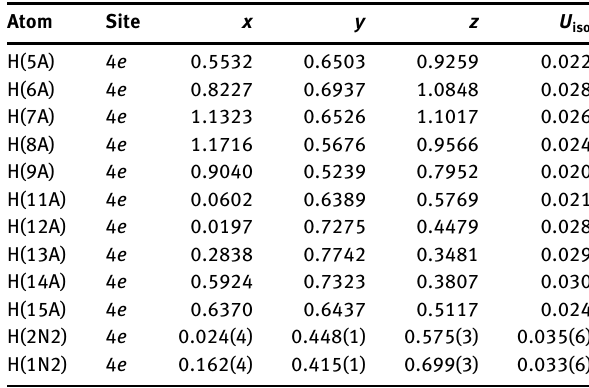
Table 2: Fractional atomic coordinates and isotropic or equivalent isotropic displacement parameters (Å 2